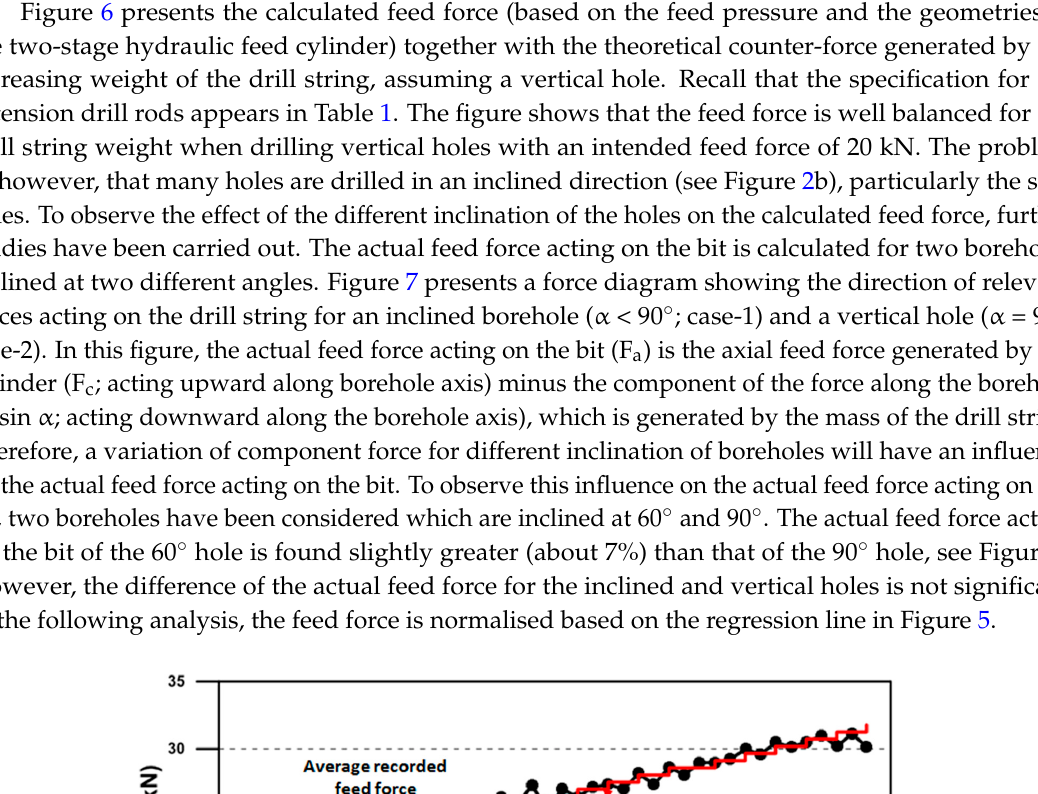
Figure 5. Feed pressure versus hole length.